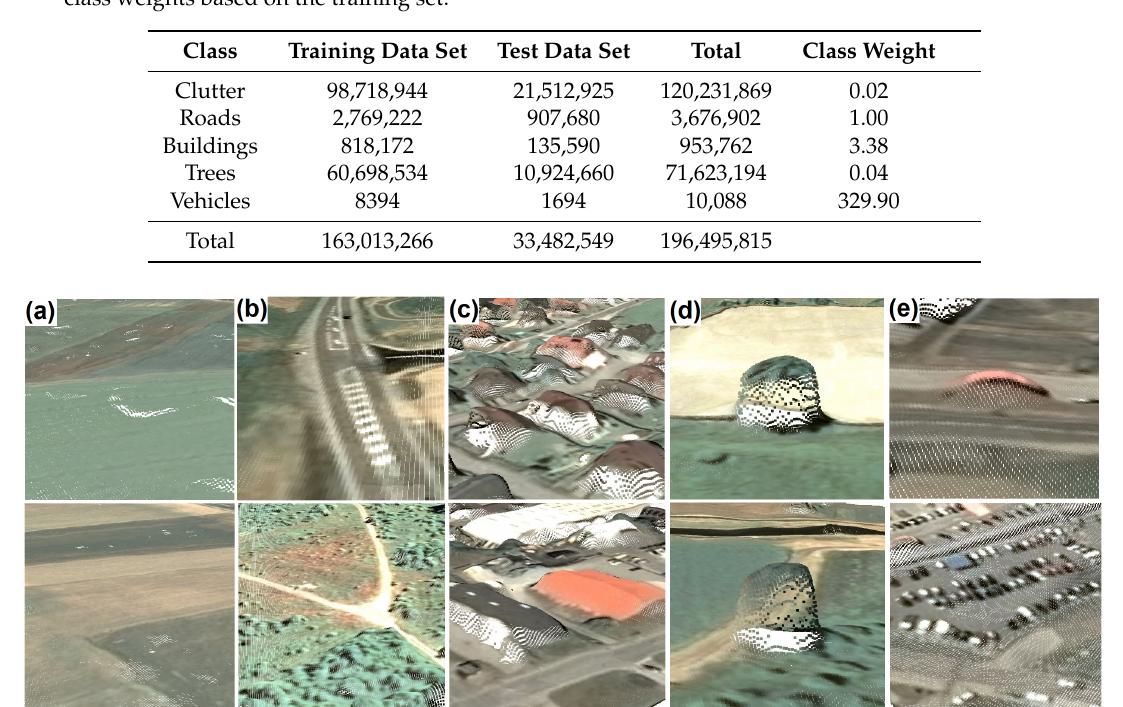
Figure 4. Examples of point clouds derived from tri-stereo satellite imagery for each class: ( a ) clutter; ( b ) roads; ( c ) buildings; ( d ) trees; and ( e )